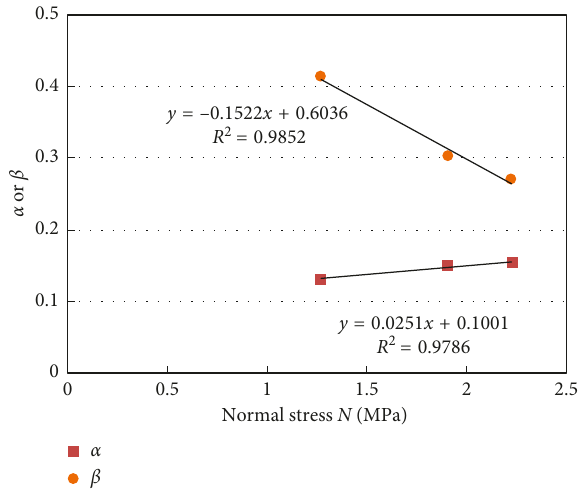
Figure 14: Change of α , β with normal stress N . Table 5: α and β for different normal stresses. Normal stress N